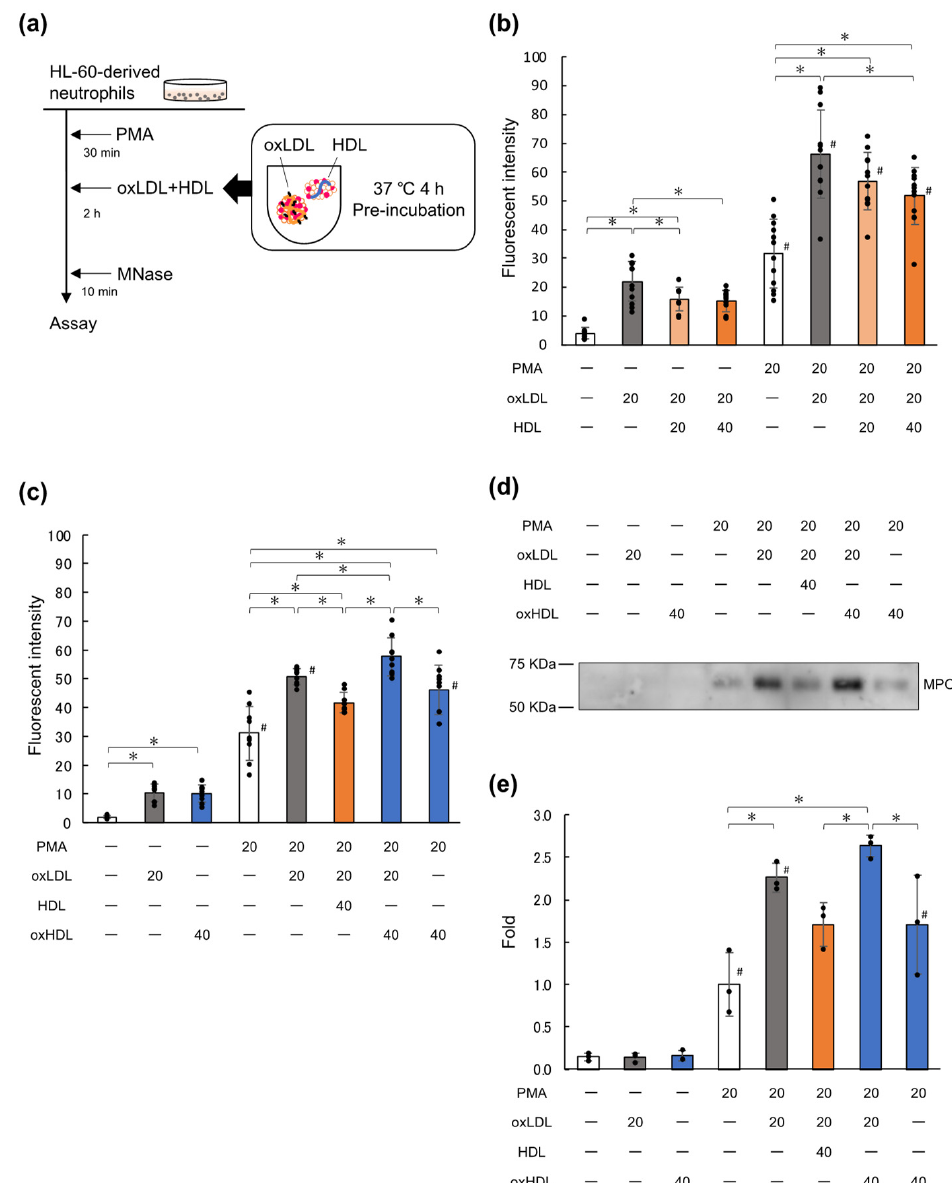
Figure 1. HDL attenuates the oxLDL-enhanced NET formation of HL-60-derived neutrophils. ( a ) Experimental scheme. OxLDL was pre-incubated with native HDL or oxHDL at 37 °C for 4 h, before being added to the cells. HL-60 cells were differentiated into neutrophil-like cells using 2 µ M AtRA treated with or without 20 nM PMA for 30 min, and then treated with lipoproteins for 2 h. The medium was treated with 1 U/mL MNase for 10 min in order to cleave the DNA into short segments. The fluorescence intensity of the medium supernatant was then measured using 1 µ M SYTOX ® Green. ( b ) Effect of native HDL on oxLDL-mediated NET formation. OxLDL (20 µ g/mL) was pre-incubated without HDL or with 20 or 40 µ g/mL HDL for 4 h, following which the lipoproteins were added to the neutrophils for 2 h. The data represent the mean ± SD of four experiments, each carried out in triplicate; each dot represents one data point. ( c ) Effect of oxHDL on oxLDL-mediated NET formation. Cells primed using PMA were incubated with 20 µ g/mL oxLDL in the presence of 40 µ g/mL native HDL or oxHDL for 2 h. In addition, some cells were incubated with oxHDL alone, for 2 h. The data represent the mean ± SD from three experiments, each carried out in triplicate. ( d , e ) The MPO released in the medium was detected using Western blot in aliquots of the culture super- natant obtained in ( c ). A representative Western blot ( d ) and its quantification using ImageJ software ( e ) have been shown. The data are shown as the relative value to the band intensity of the control sample (no lipoprotein after PMA treatment). The data from three runs are shown. Asterisks indi- cate statistical significance (* p < 0.05), while sharps indicate statistical significance against the cor- responding conditions without PMA (# p < 0.05). HDL, high-density lipoprotein; NETs, neutrophil extracellular traps; oxLDL, copper-oxidized low-density lipoprotein; oxHDL, copper-oxidized high- density lipoprotein; AtRA, all- trans retinoic acid; PMA, phorbol 12-myristate 13-acetate; MNase, micrococcal nuclease; MPO, myeloperoxidase.